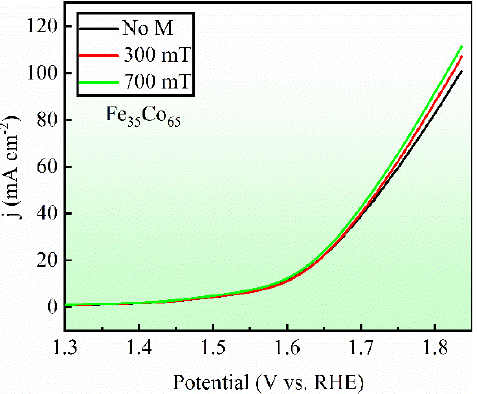
Figure 7. LSV curve of sample Fe 35 Co 65 under different magnetic field gradients.